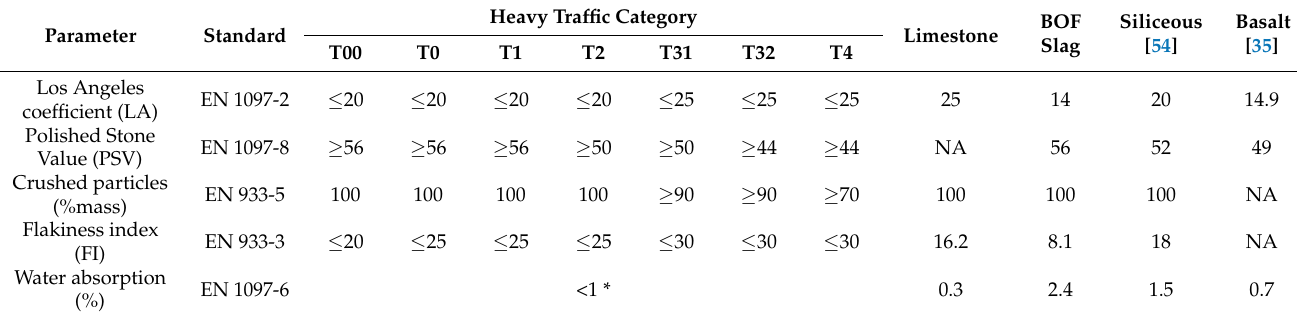
Table 4. Requirements of coarse aggregates to be used in wearing